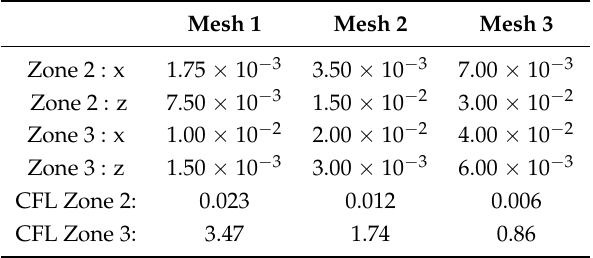
Table 1. Cell height of the mesh used for the convergence study. Mesh